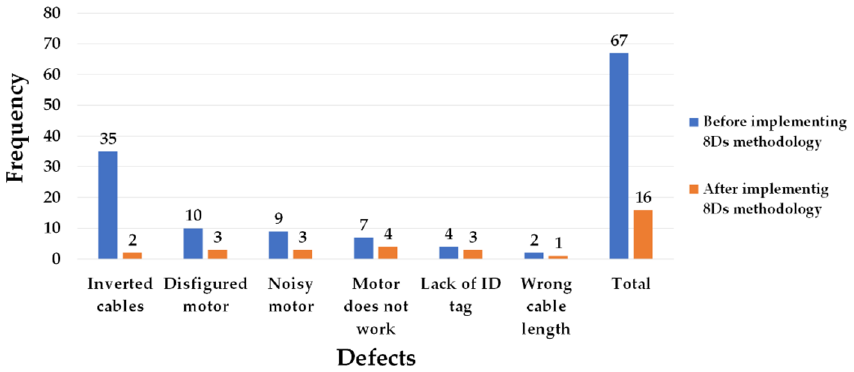
Figure 12. Comparison of the frequency of defects before and after applying the 8Ds method.